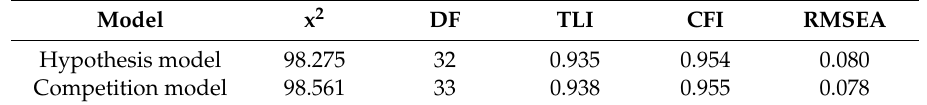
Table 9. Goodness-of-fit indices of hypothesis and competition